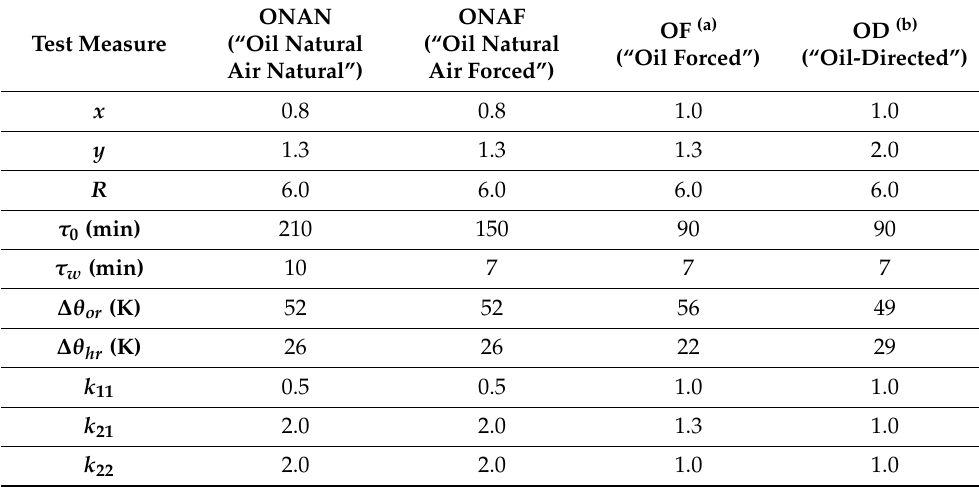
Table 11. Transformer oil quality tests and their limits for different cooling